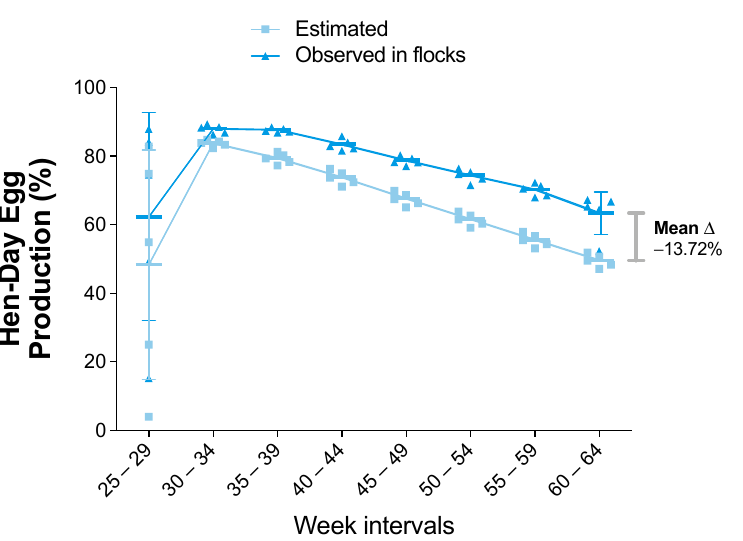
Figure 2. Percentages of hen-day egg production (HDEP) for estimated and observed flocks. Results are presented as mean and standard deviation, and mean differences (shown as delta “ ∆ ” mean) were calculated subtracting observed from estimated values. Comparisons were performed using the two-way ANOVA test followed by the Bonferroni correction post-hoc test.